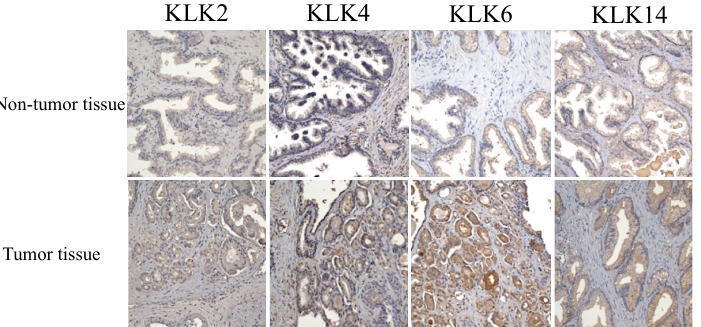
Figure 4. The immunostaining of KLK proteins showed significant differences in PCa tissues. The results show that the KLK2, KLK4, KLK6, and KLK14 proteins were significantly elevated compared with normal tissues in the nucleus and cytoplasm. The scale of the picture is 50 µ m with a 2.0 × objective lens.